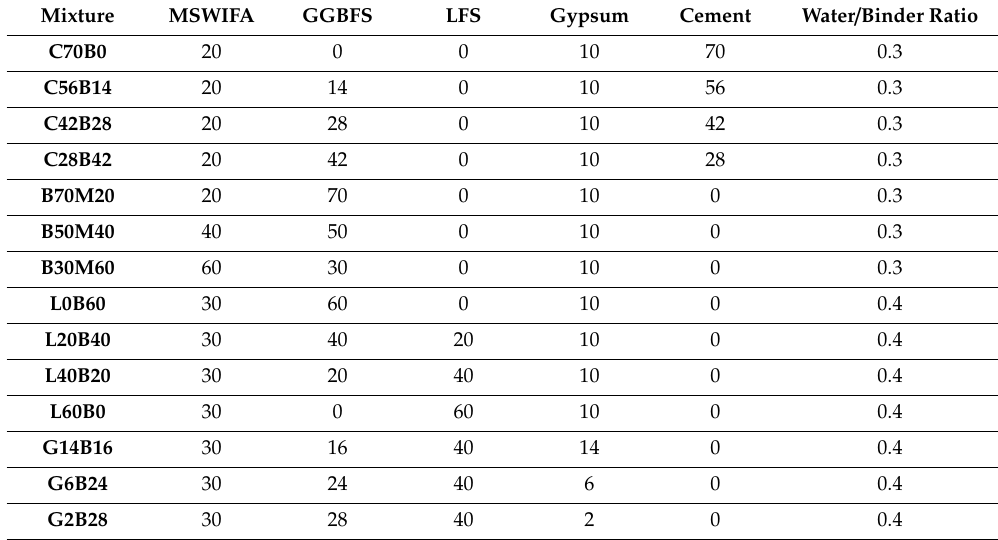
Table 2. Mixture designs used in the study (in mass %); water / binder is unitless